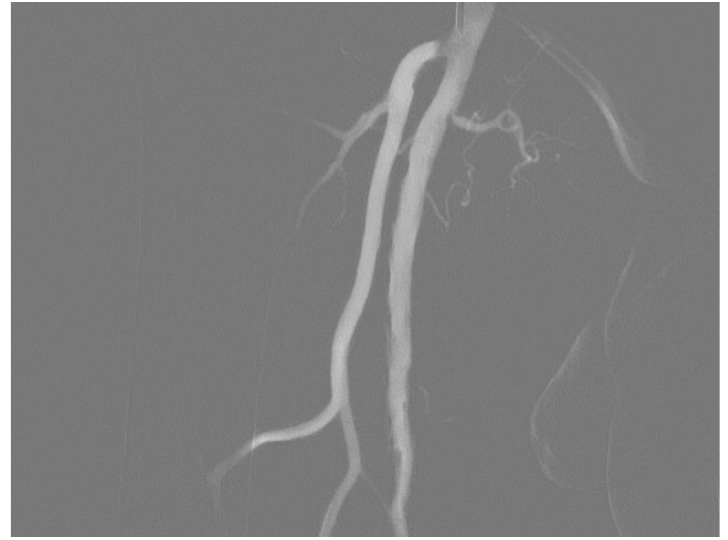
Figure 1. Subtracted image (roadmap) showing common femoral artery and its bifurcation. To optimize and improve arterial vessel visualization in the lower limb, endovascular administration of vasodilator drugs can be performed, the most used being nitroglycerin and papaverine